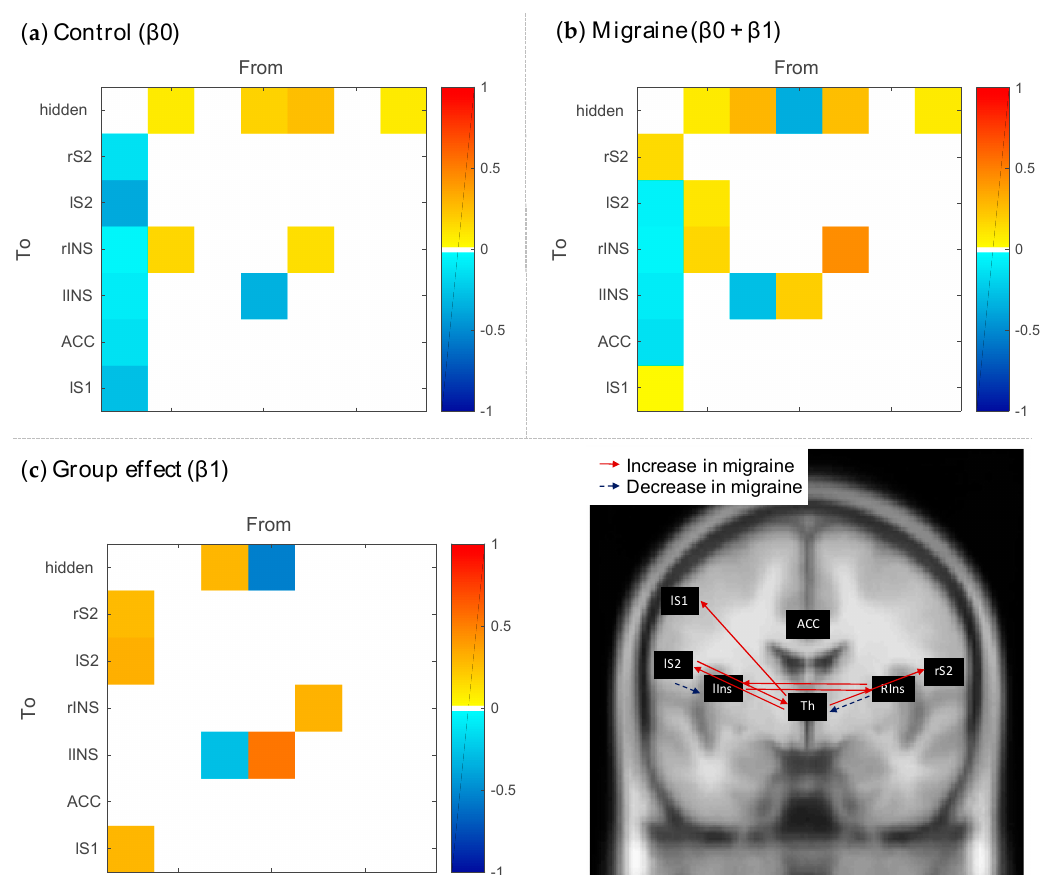
Figure 4. Parametric empirical Bayes results comparing connectivity modulations between groups. ( a ) Group mean modulation of connectivity for the control group. ( b ) Group mean modulation of connectivity for the migraine group. ( c ) Connectivity modulations that show a group effect. Only parameters with a posterior probability of being different from zero >0.99 are colored in the left panel and visualized as arrows on an anatomical scan in the right panel.